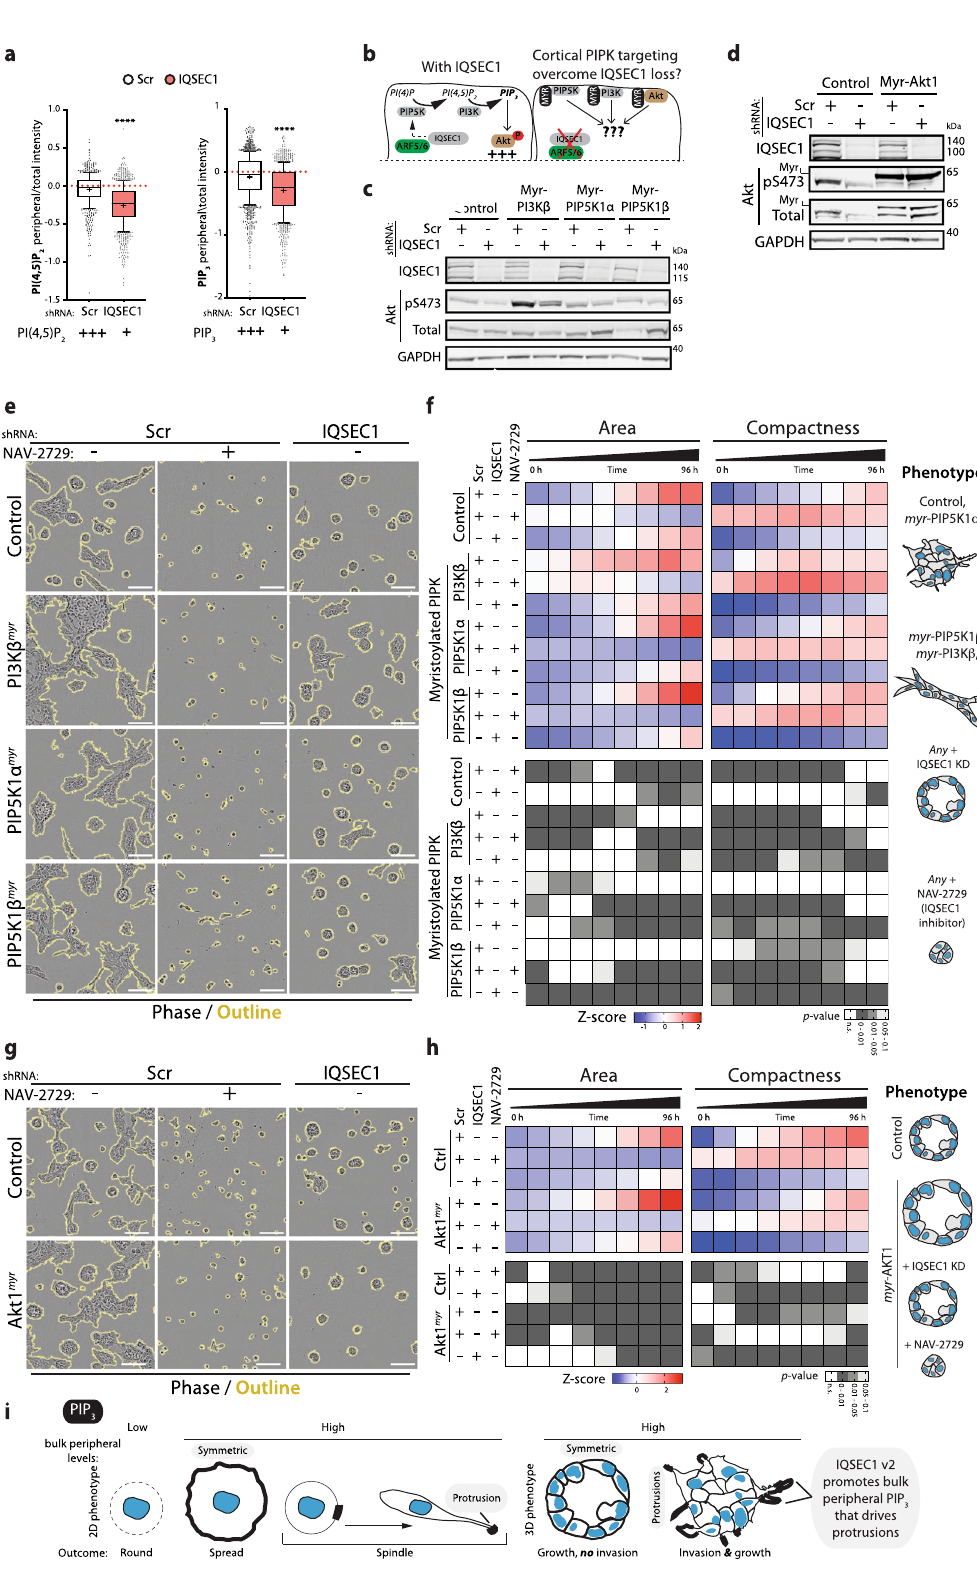
(RPPA) data. Within each cancer type IQSEC1 expression was divided into high and low using a median split of mRNA levels, and protein differences between each group that consistently and signi fi cantly trended in the same direction across a quarter of all cancer types was calculated (Supplementary Fig. 11e). Mirroring IQSEC1 regulation of phosphoinositide signalling in PC3 cells, a